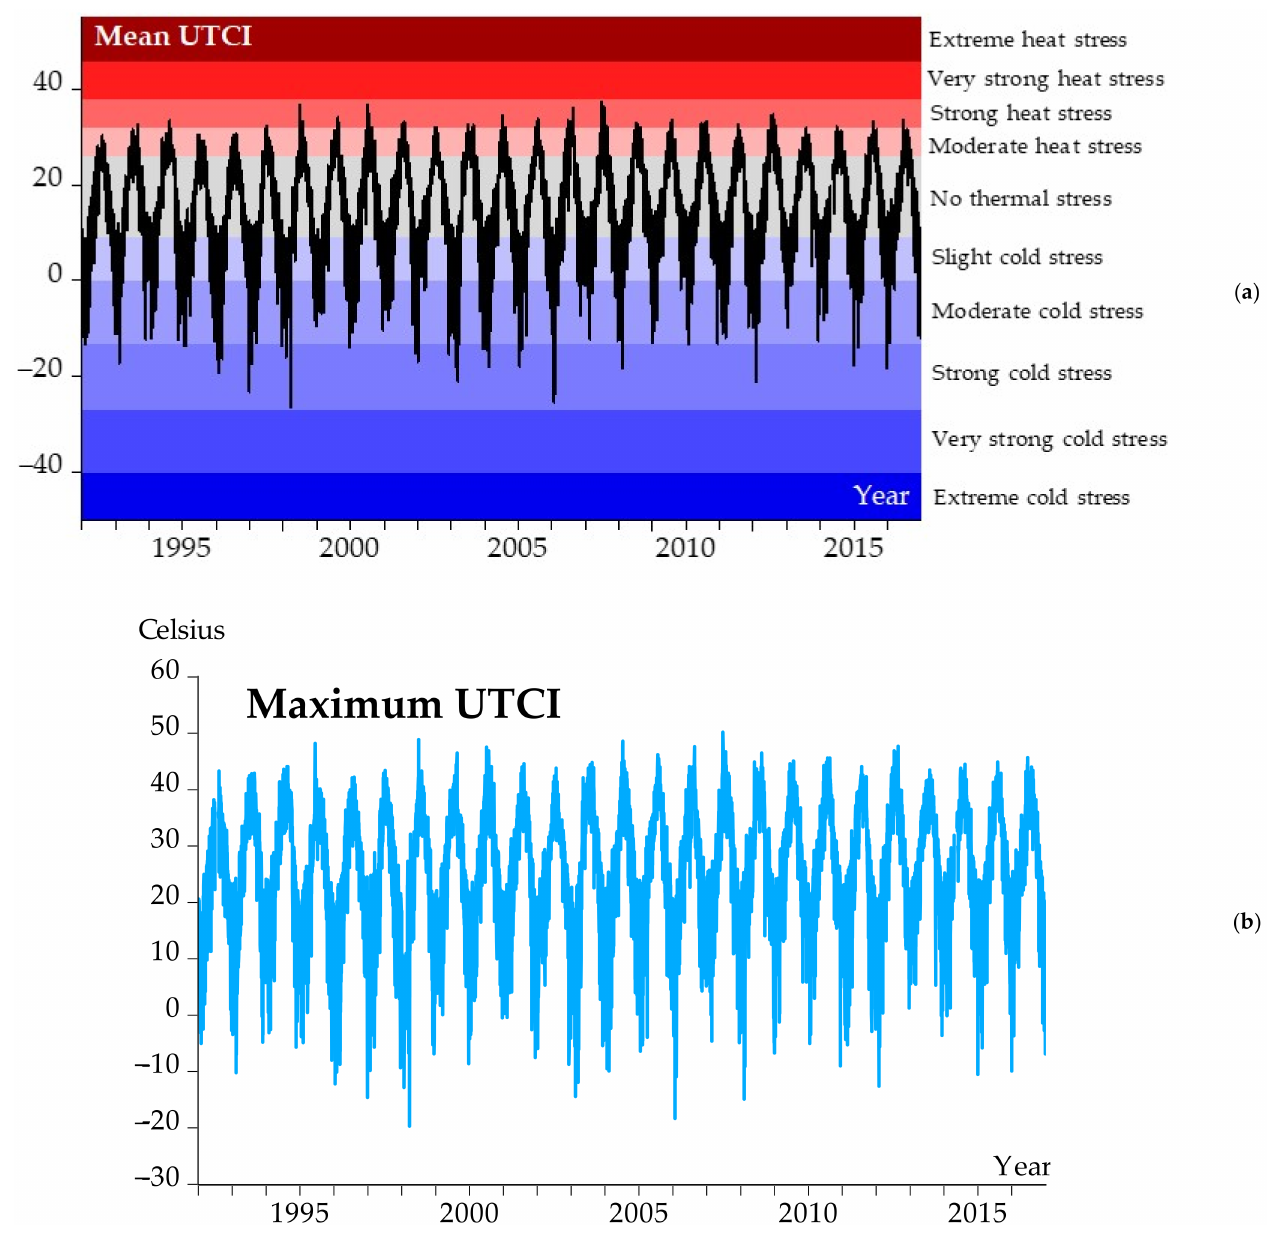
Figure 4. UTCI graphs of mortality for Attica: ( a ) Graph of mean UTCI; ( b ) graph of maximum UTCI. In order to define heatwaves for the case of Attica, six indicators (mean and maximum temperature, mean and maximum PET, and mean and maximum UTCI), five percentiles (90, 92.5, 95, 97.5, and 99th) and two durations of the heatwave event (greater than or equal to 2 and 3 days) are used. Table 1 presents the descriptive statistics concerning mortality for two different seasons, i.e., winter and summer (specifically, winter months are December, January and February, while summer months are June, July and August). As shown, mortality for all the causes under examination in the present paper, is higher in winter compared to summer, when it comes to minimum and mean values. Our results agree with previous studies in the relevant literature [4,32]. Nonetheless, during summer, the maximum values of cardiological and cardiorespiratory mortality is higher than the respective values during